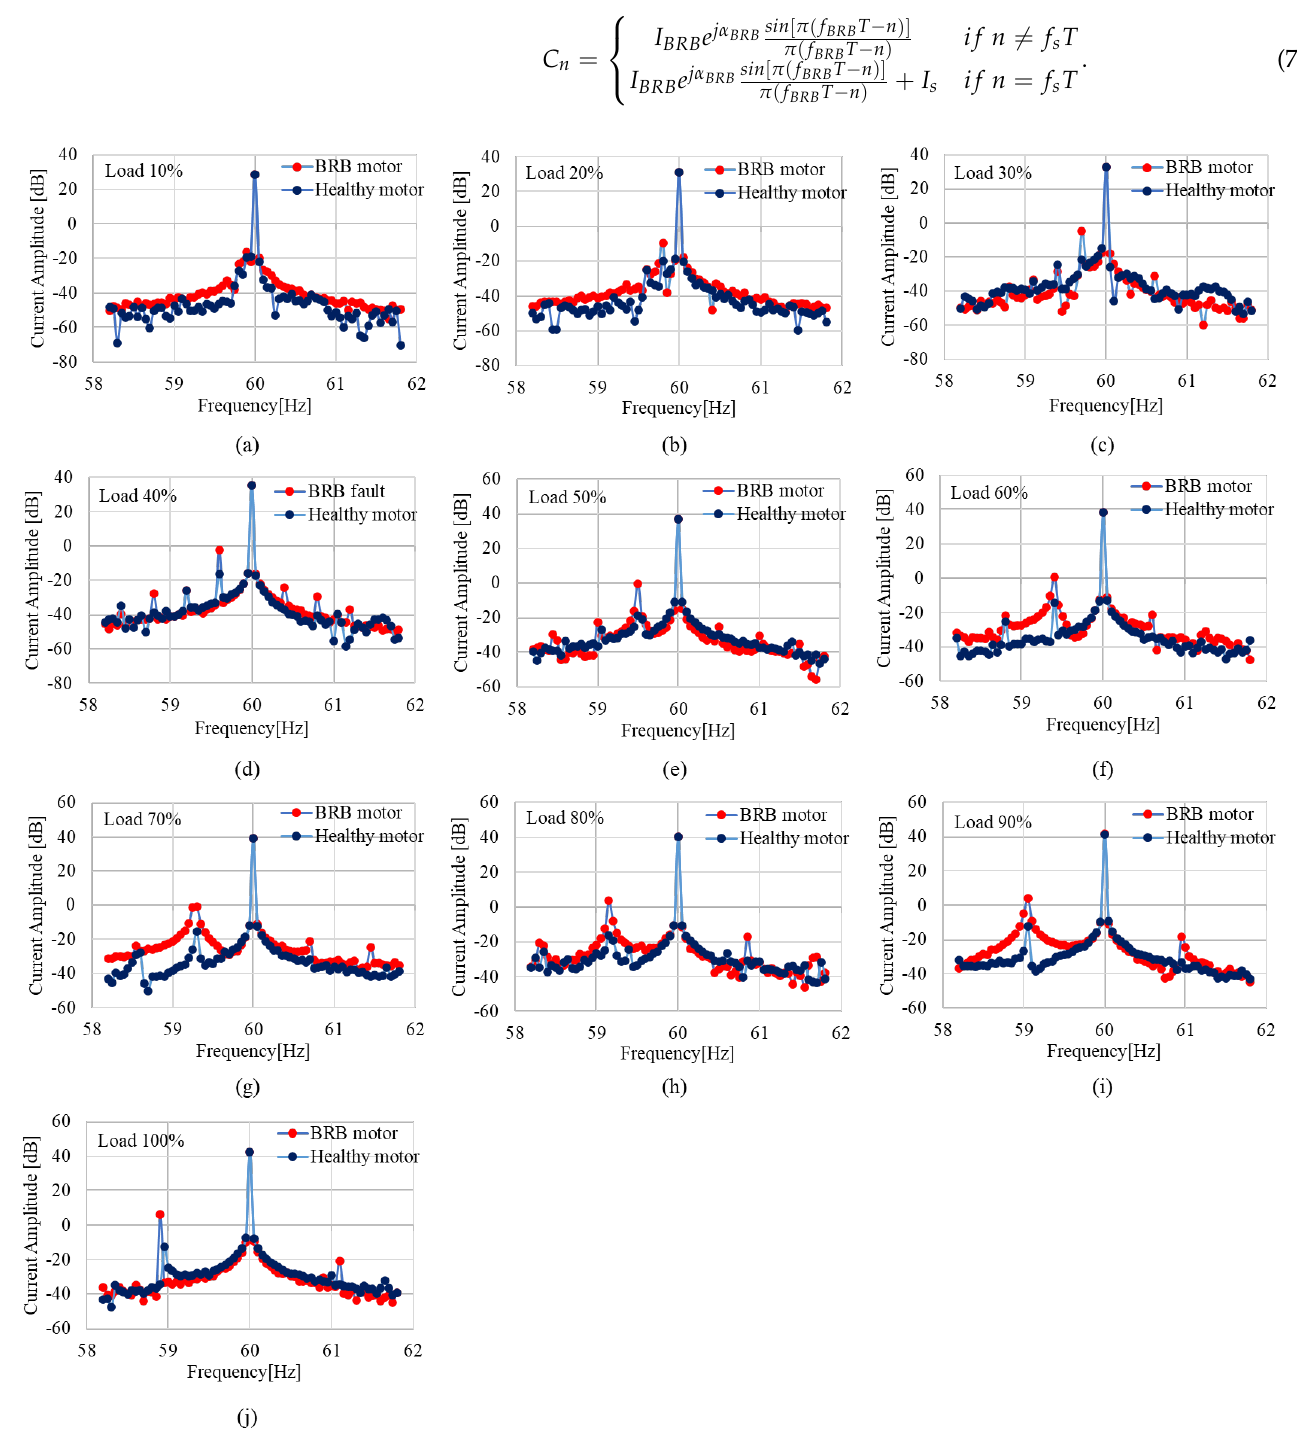
Figure 4. Fourier series results of the BRB fault and healthy motor with T = 20 s and ( a ) 10%, ( b ) 20%, ( c ) 30%, ( d ) 40%, ( e ) 50%, ( f ) 60%, ( g ) 70%, ( h ) 80%, ( i ) 90%, and ( j ) 100%.